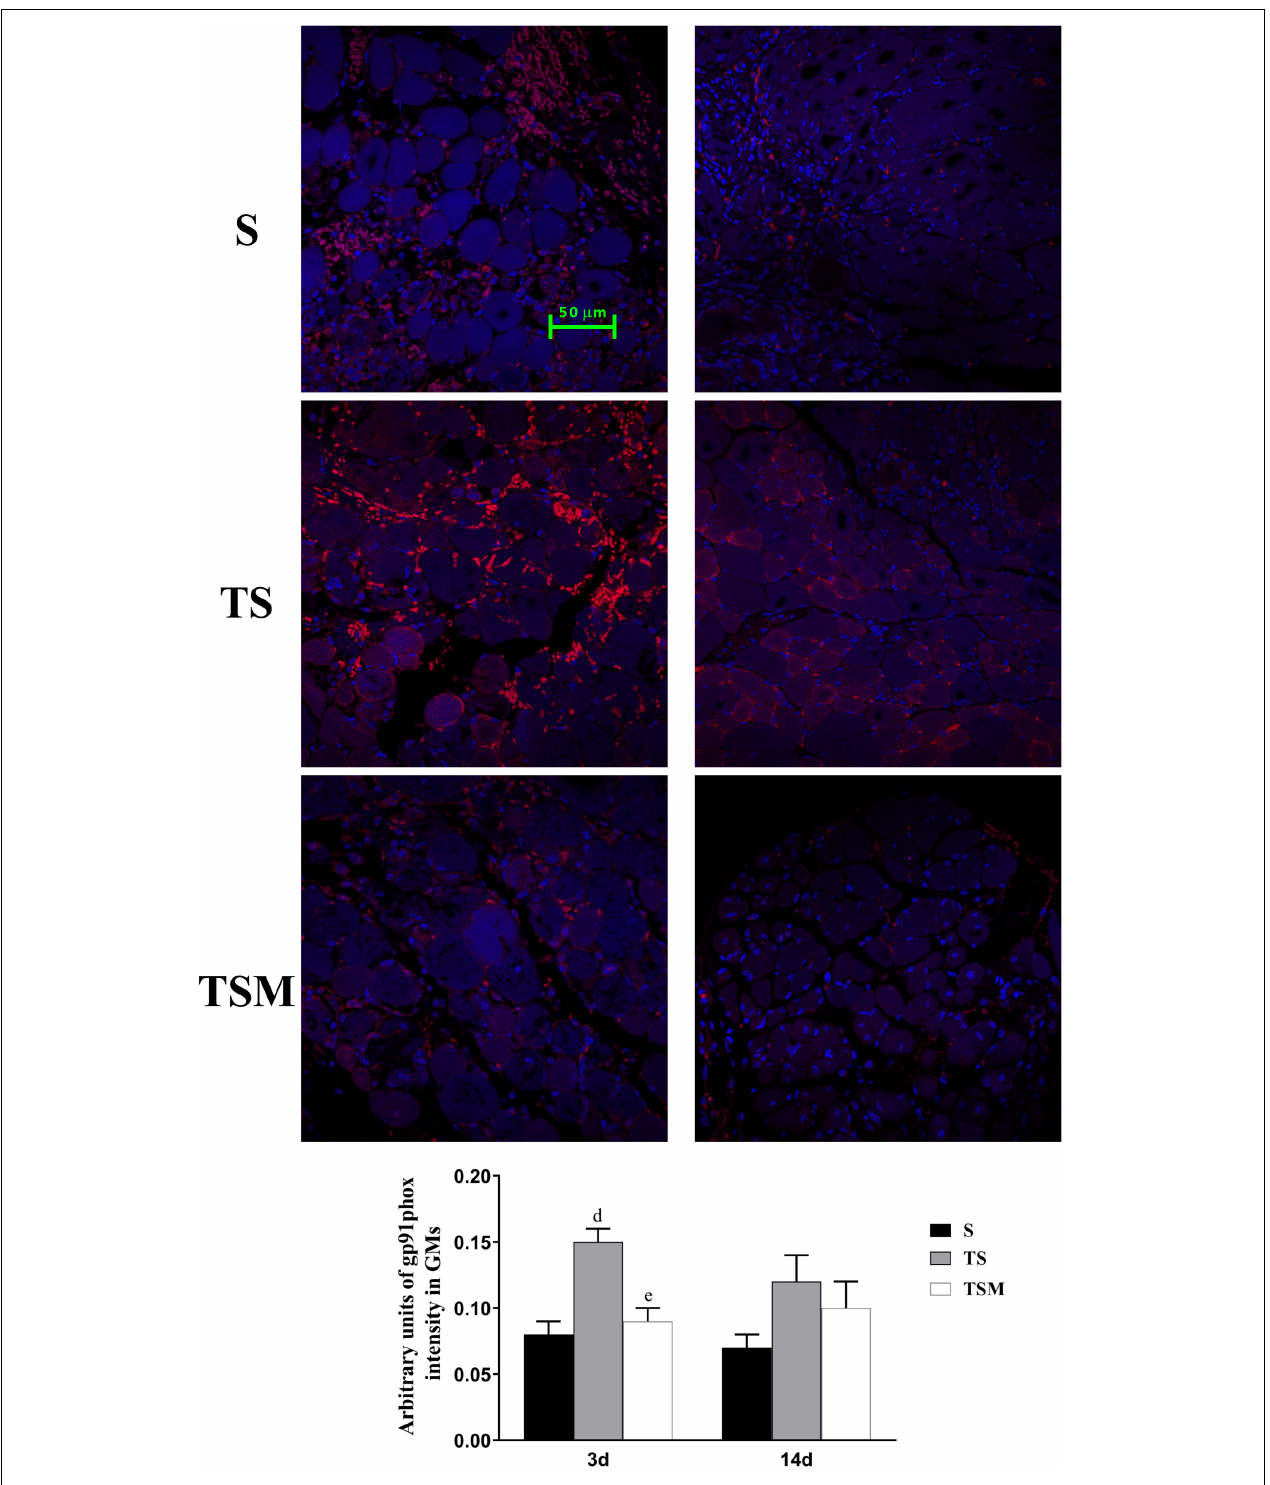
FIGURE 10 | Effects of MGF injection on the expression of gp91phox in injured skeletal muscle after macrophage depletion. S, muscle contusion group; TS, muscle contusion and macrophage depleted group; TSM, muscle contusion, macrophage depletion and MGF treated group. Data are means ± SEM, n = 8; a Significant difference from Scon, p < 0.05; aa p < 0.01. b Significant difference from TScon, p < 0.05; bb p < 0.01. c Significant difference from TSMcon, p < 0.05; cc p < 0.01; d Significant difference between group TS and group S, p < 0.05; dd p < 0.01; e Significant difference between group TS and group TSM, p < 0.05; ee p < 0.01; f Significant difference between group TSM and group S, p < 0.05; ff p < 0.01.